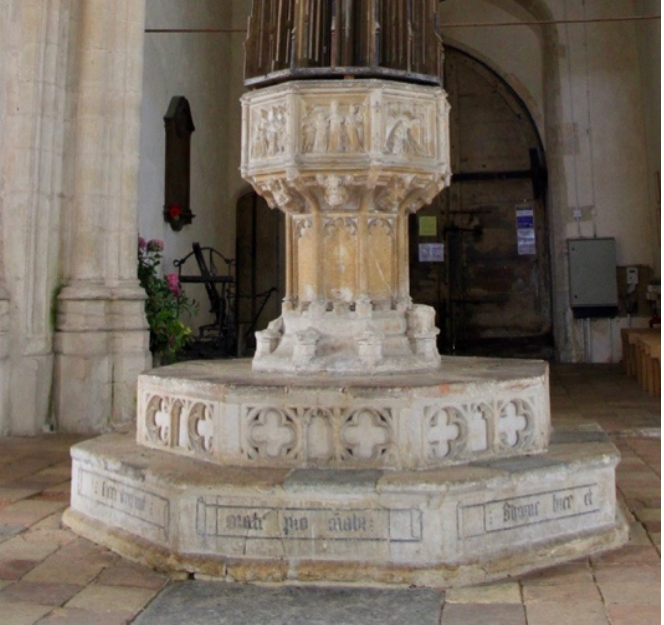
Figure 8. The font at Salle, showing the inscription on the risers.